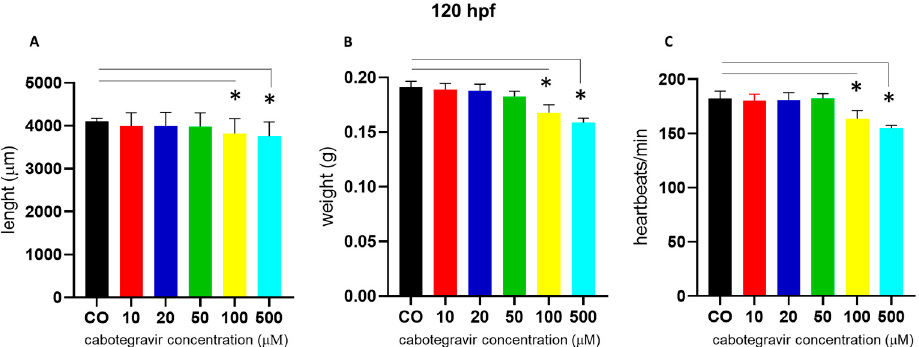
Figure 3. Effects of cabotegravir (CAB) exposure of zebrafish embryos (immersion method) on length, weight, and heartbeat at 120 h post fertilization (hpf). Dechorionated embryos were exposed by the immersion method to different drug doses at gastrula stage (4 hpf) up to 120 hpf. CAB was dissolved in fish water containing 0.1% dimethyl sulfoxide (DMSO). Control embryos [CO] were treated with fish water and 0.1% DMSO. X-axis shows drug doses used for exposure of embryos; Y-axis shows: ( A ) length ( μ m), ( B ) weight (g), and ( C ) heartbeats/min. Results are expressed as mean ± SD of three independent experiments, with 30 embryos for each experiment and each treatment. (* p < 0.05 vs. control group).